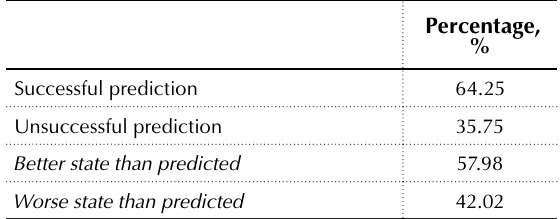
Table 3. Robustness check of the prediction